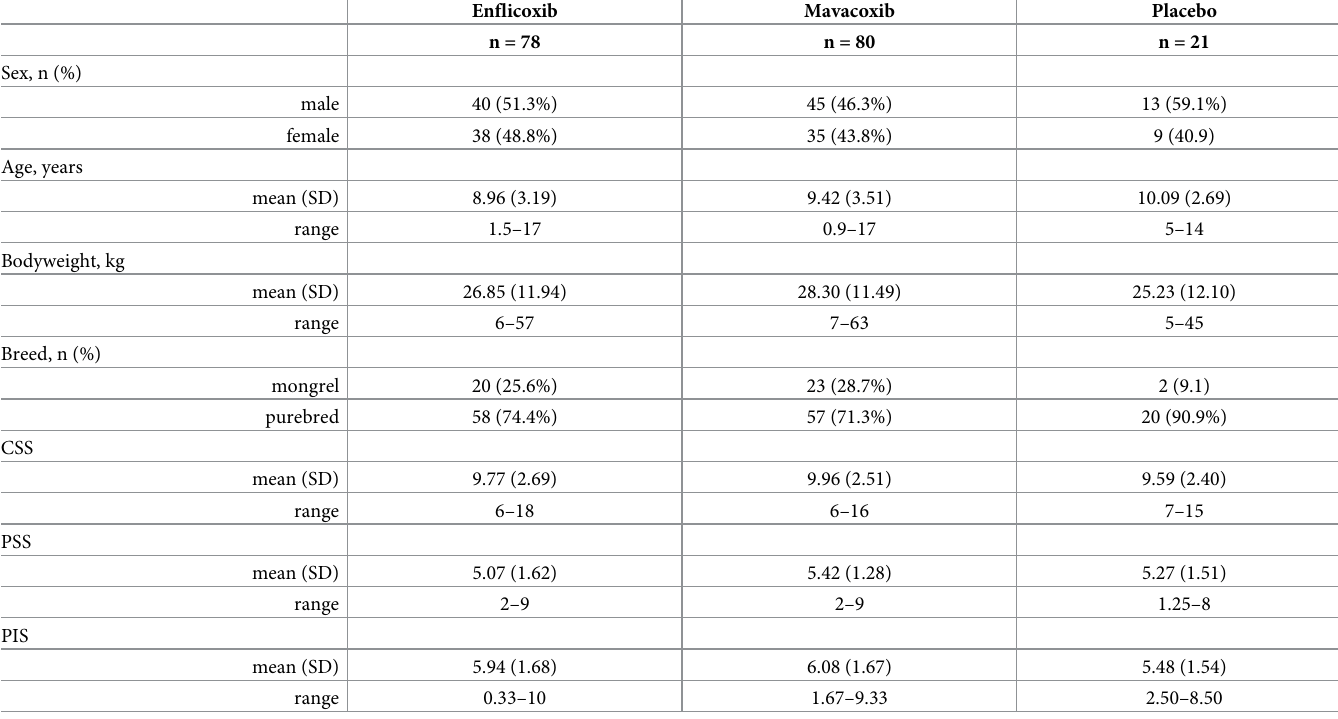
Table 1. Demographic data and CSS, PSS and PIS basal scores for the ITT population. Enflicoxib Mavacoxib